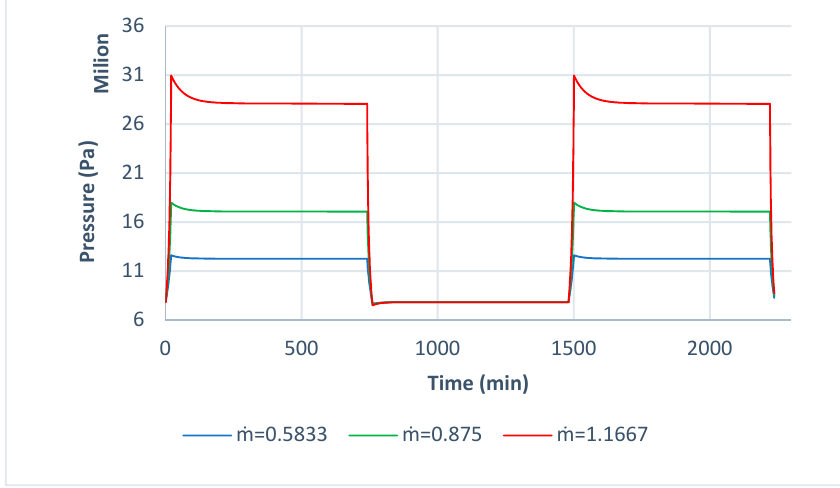
Figure 6. Pressure gas trend for the First Configuration varying the liquid flow rate.